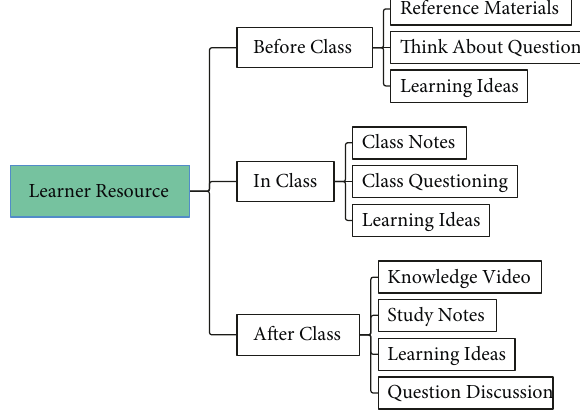
Figure 4: Composition diagram of learner